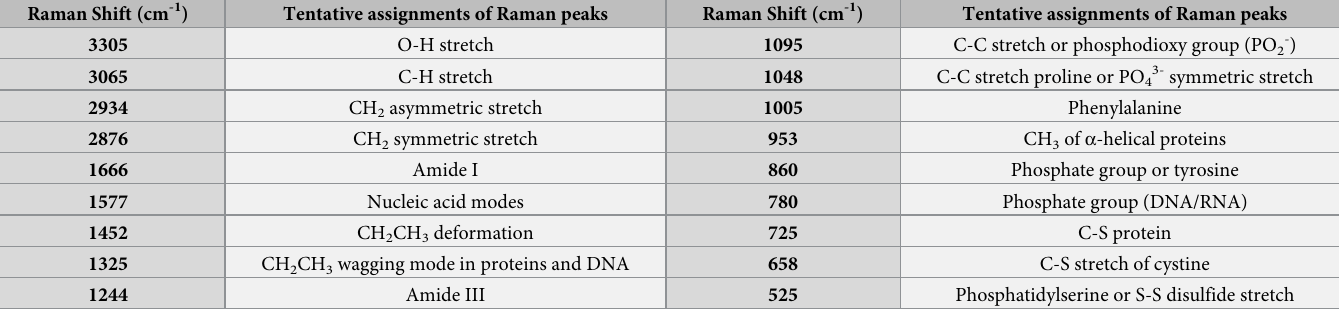
Table 1. Tentative assignment of Raman peaks for the characterisation of the biological composition of T. b. brucei using previously published works from biologi- cal samples [31,41,42]. Raman Shift (cm -1